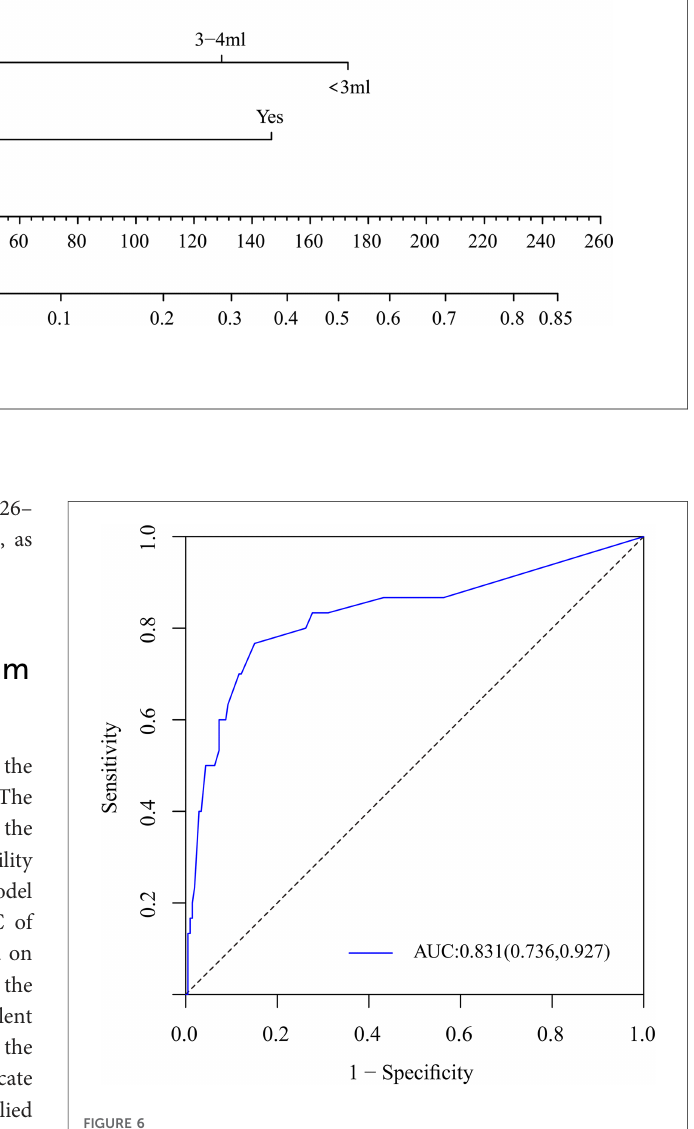
FIGURE 6 ROC curves of the nomogram for the assessment of capable of accurate prediction and